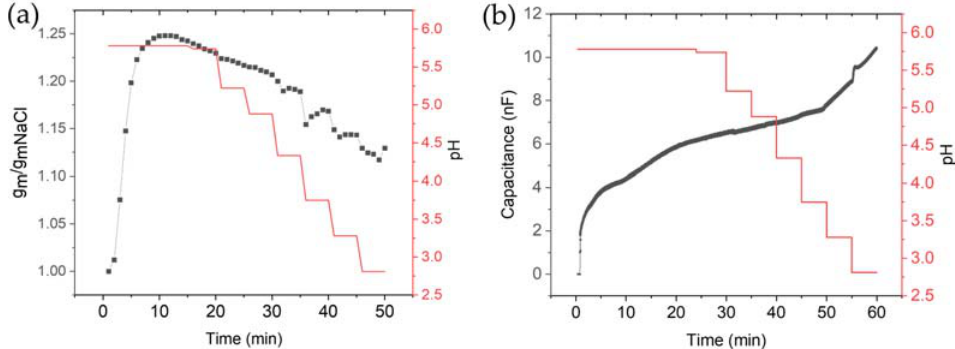
Figure 5. Time dependences during HCl adding every 5 min for: ( a ) the transconductance; ( b ) the capacitance between the gate and the drain electrodes. The data were obtained using the devices on Si/SiO 2 substrates.